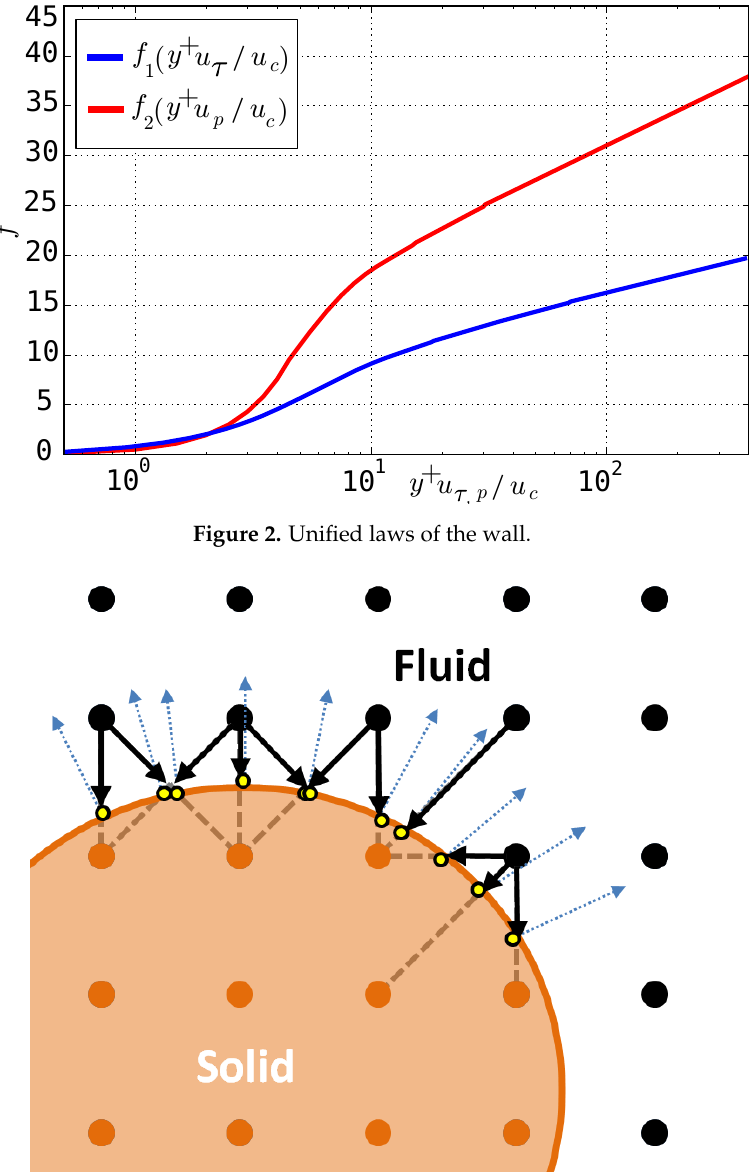
Figure 3. Wall distance and curvature